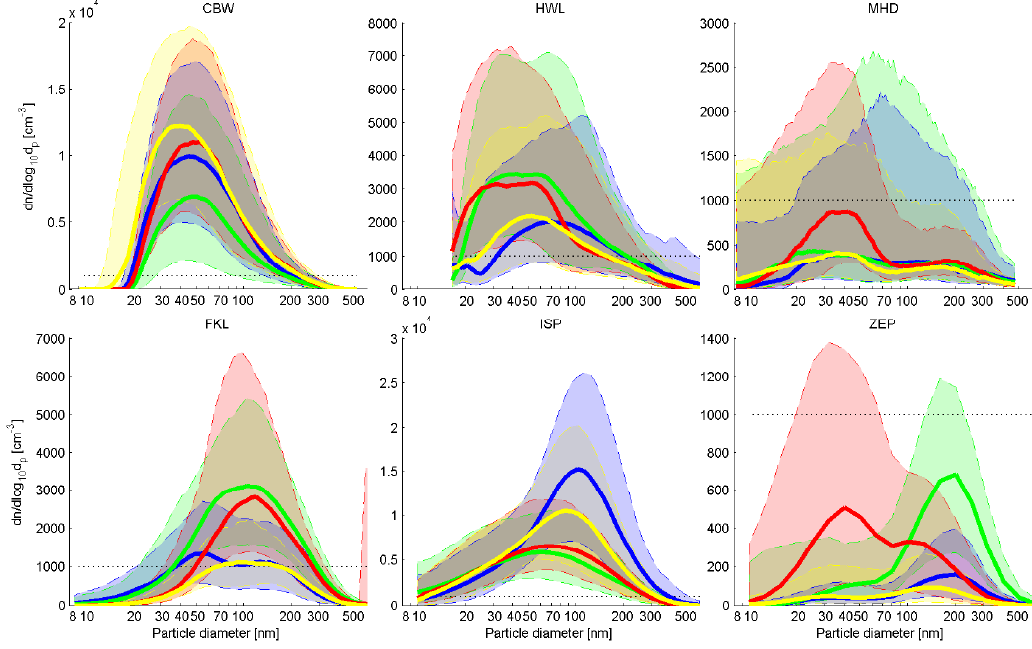
Fig. 7. Median distributions (solid line) and 16th and 84th percentile distributions (shaded areas) divided by seasons at West European, Arctic and Mediterranean stations. Notation as in Fig. 4